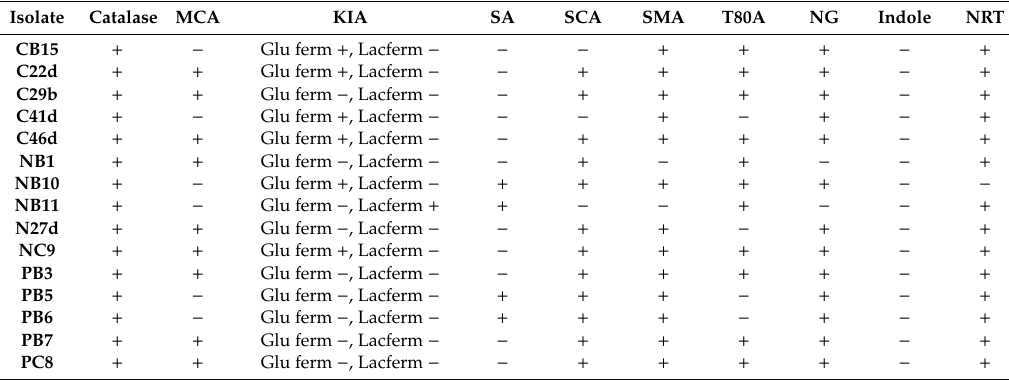
Table A2. Biochemical properties of selected functional bacterial